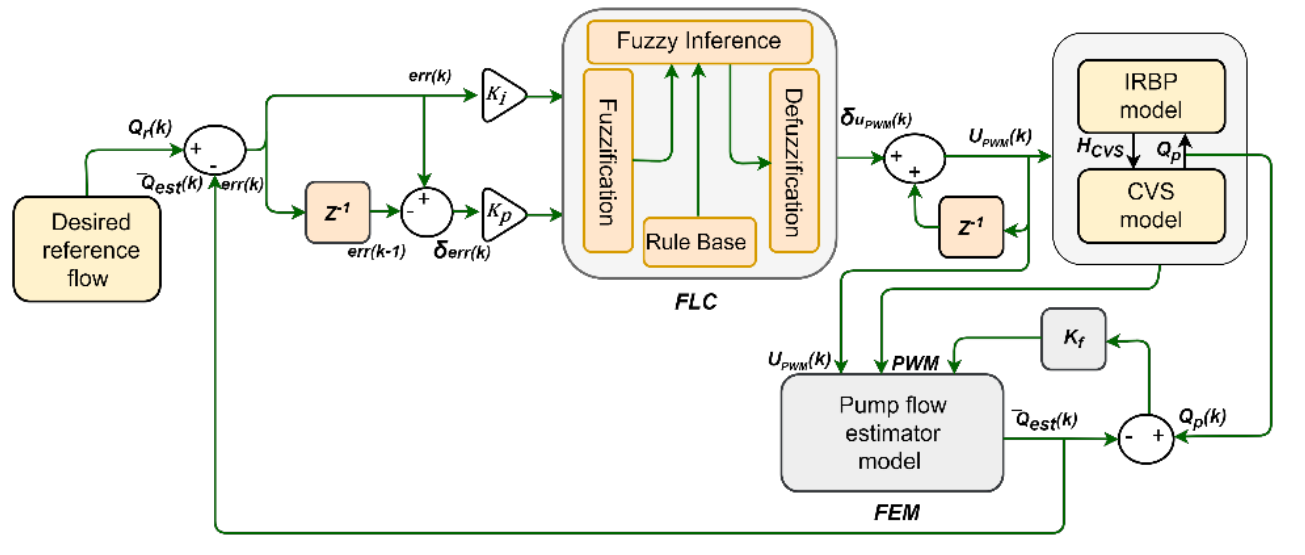
Figure 2. Schematic representation of the proposed system. CVS: cardiovascular system; IRBP: im- plantable rotary blood pump; FLC: fuzzy logic control; 𝐻 𝑐𝑣𝑠 : differential pressure; FEM: flow